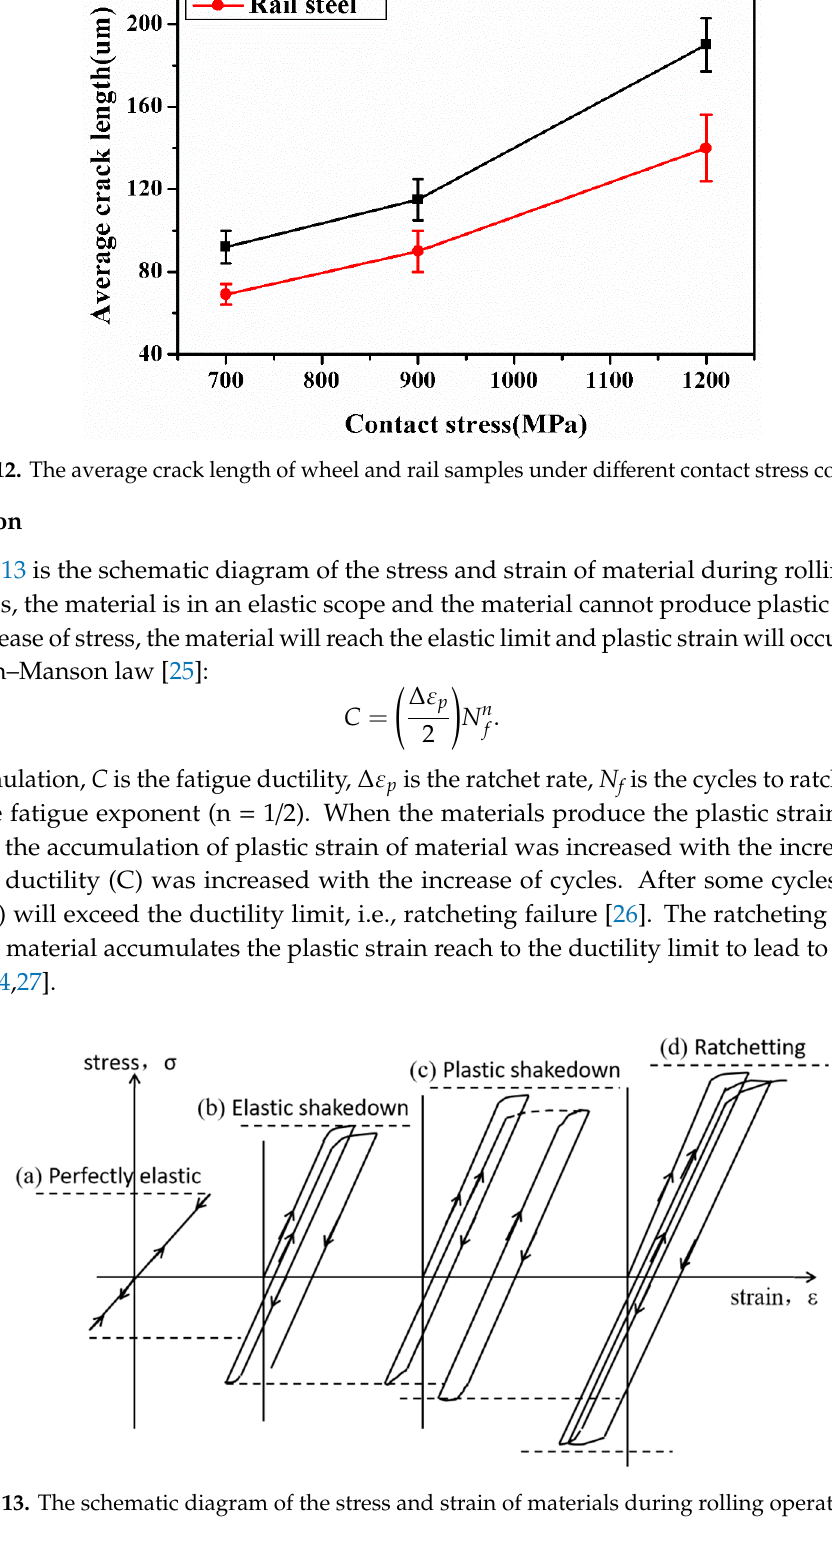
Figure 11. The surface wear morphology of wheel and rail samples under different contact stress